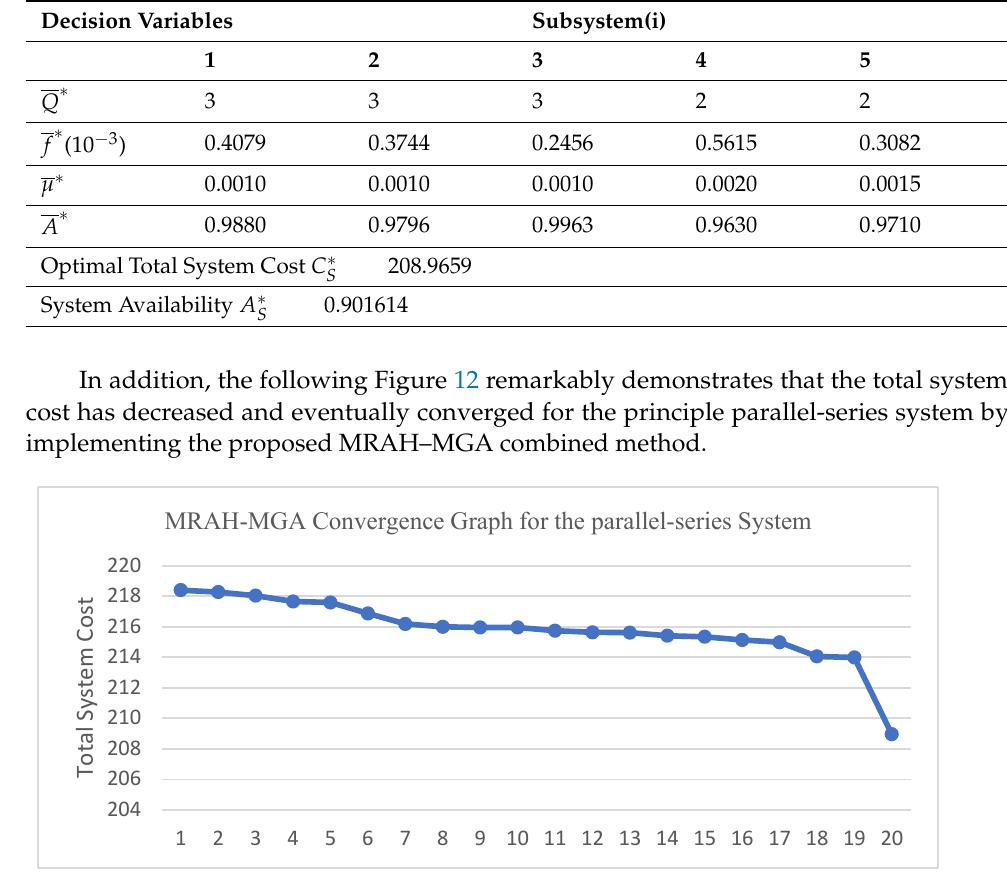
Table 24. Optimal Solutions obtained by MRAH–MGA for the parallel-series system.